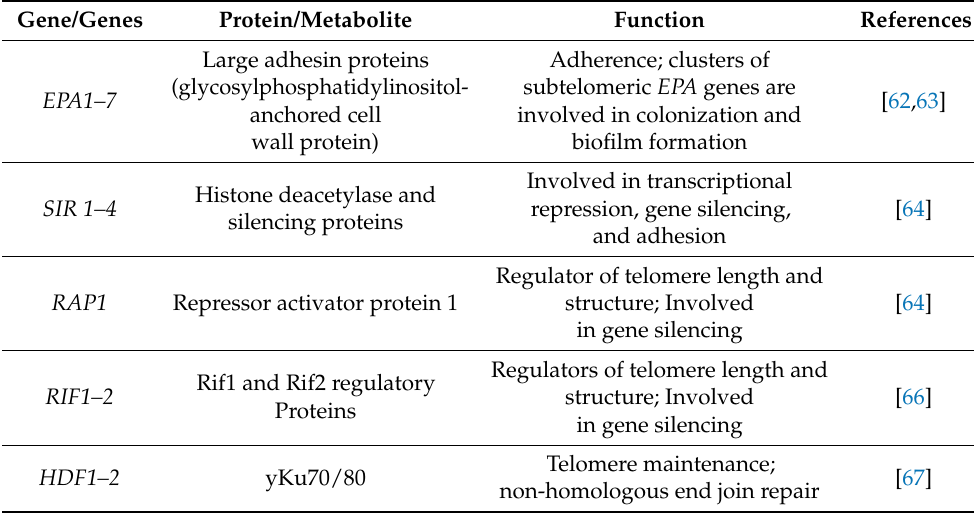
Table 4. Subtelomeric genes that increase pathogenicity in C. glabrata